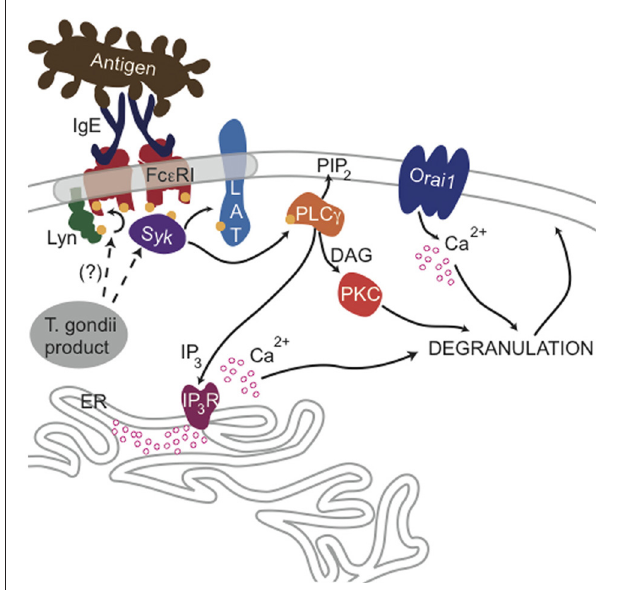
FIGURE 8 | Ca 2 + -mediated signaling through Fc ε RI is blocked by a T. gondii -secreted product. Crosslinking of IgE/Fc ε RI complexes by multivalent antigen leads to phosphorylation of Fc ε RI subunits by Lyn kinase and subsequent recruitment and activation of Syk, which can then phosphorylate the adaptor protein LAT and other substrates. Consequent activation of PLC γ produces DAG and IP 3 , and IP 3 activates IP 3 receptors at the endoplasmic reticulum, causing Ca 2 + release from ER stores and additional influx through Orai1 channels at the plasma membrane surface. Ca 2 + mobilization and activation of PKC via DAG production is necessary for maximal degranulation of secretory lysosomes. The data presented here suggest that a secreted product of T. gondii blocks this signaling at the level of Syk phosphorylation leading to PLC γ